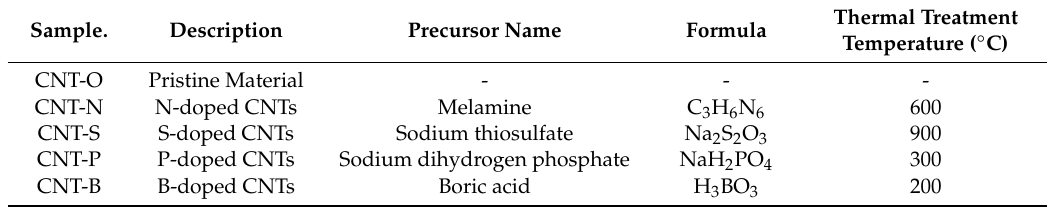
Table 1. Modified carbon nanotubes (CNT) samples